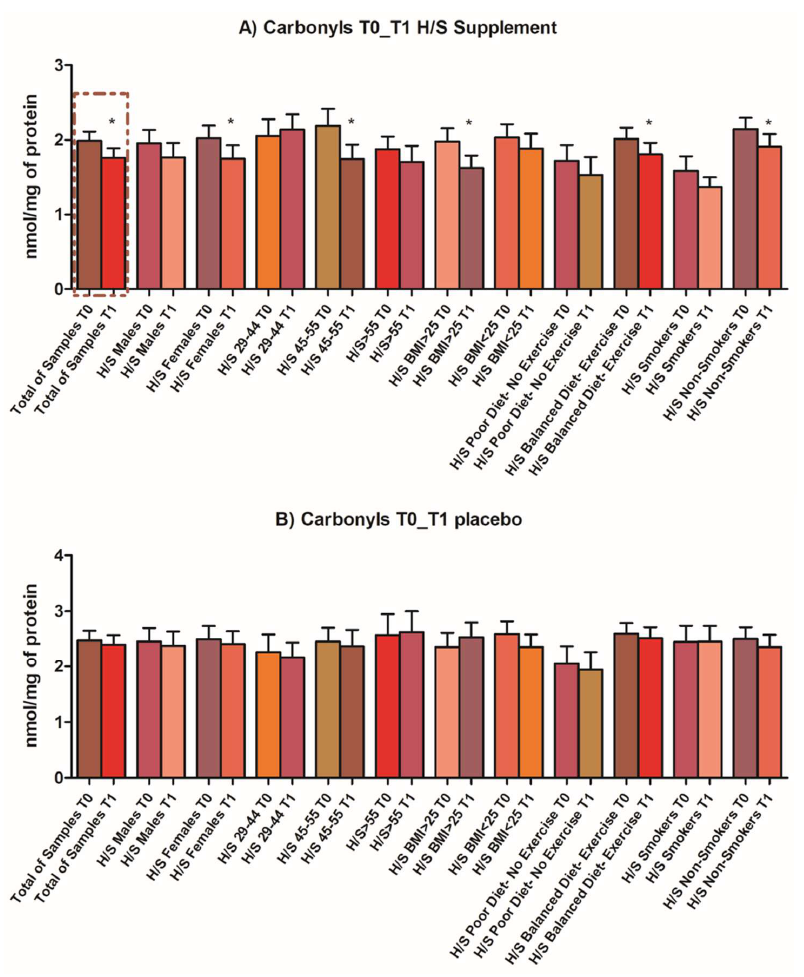
Figure 3. Antioxidant effects assessed in vivo: Levels of oxidized proteins pre- (T0) and post-intervention (T1) in the total sample (paired t-test, p -value 0.0175), as well as in distinct subgroups, adjusted for sex, age, BMI, dietary status/exercise and smoking for the intervention arm that received the capsule with active ingredients and the arm that received the placebo. The biomarker was tested in isolated human plasma. * Statistical significance between values before and after the intervention, p < 0.05.